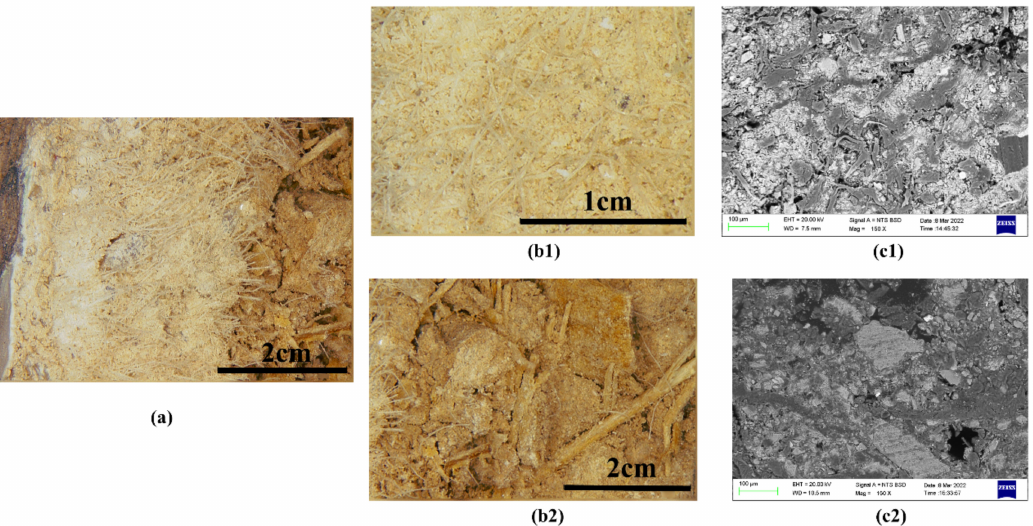
Figure 4. Coarse and fine clay layers of sample XSBD-7 from the sculpture of Sakyamuni Buddha in the Xiasibei Hall: ( a ) digital microscopy (DM) of cross-section; ( b1 ) fine clay layer; ( b2 ) coarse clay layer; (c) SEM backscattered electron mode images of fine ( c1 ) and coarse clay layer ( c2